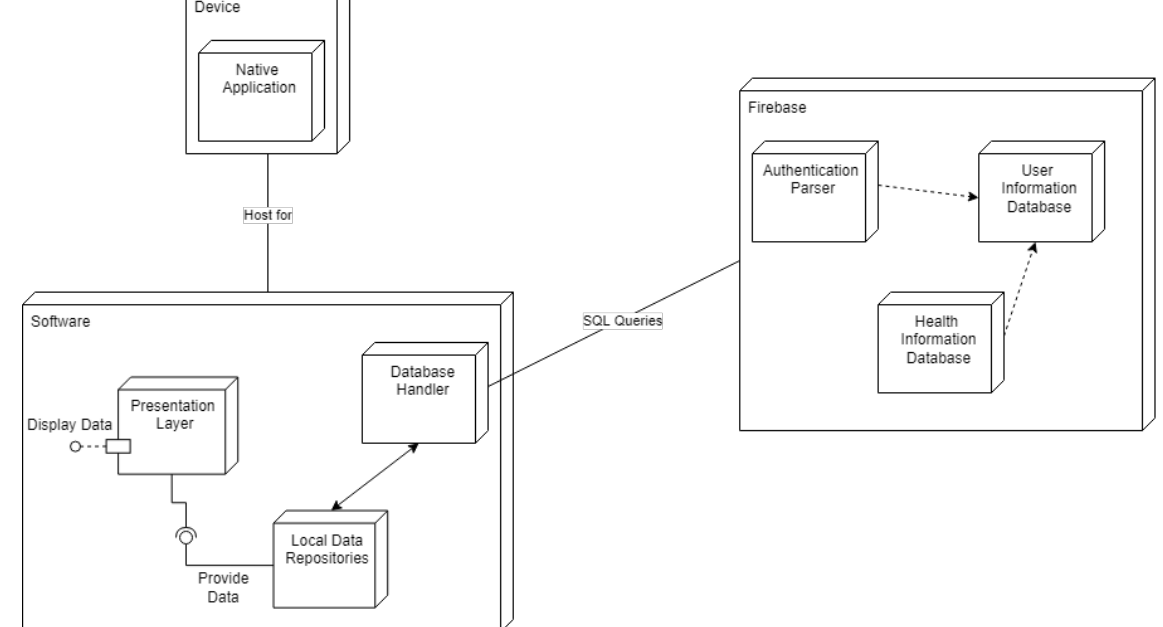
Figure 15. Deployment Diagram of Proposed